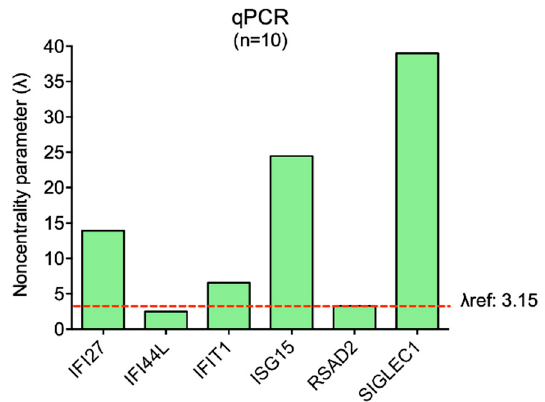
Figure 1. Graphical representation of the noncentrality parameter ( λ ) calculated for each ISG by on wet qPCR analysis. The λ ref for ten subjects is displayed by the dashed line and reported in the figure. Sample size is considered as appropriate when λ computed on each gene is higher than λ ref.